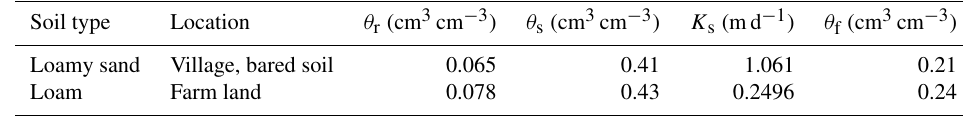
Table 4. The unsaturated hydraulic parameters of the real-world application.